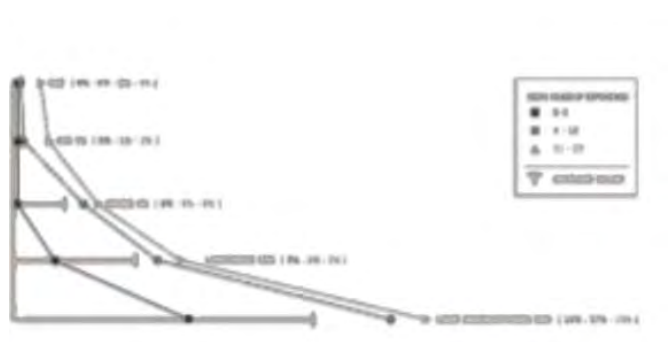
Figure 10. Architecture licensure verses Accreditation.